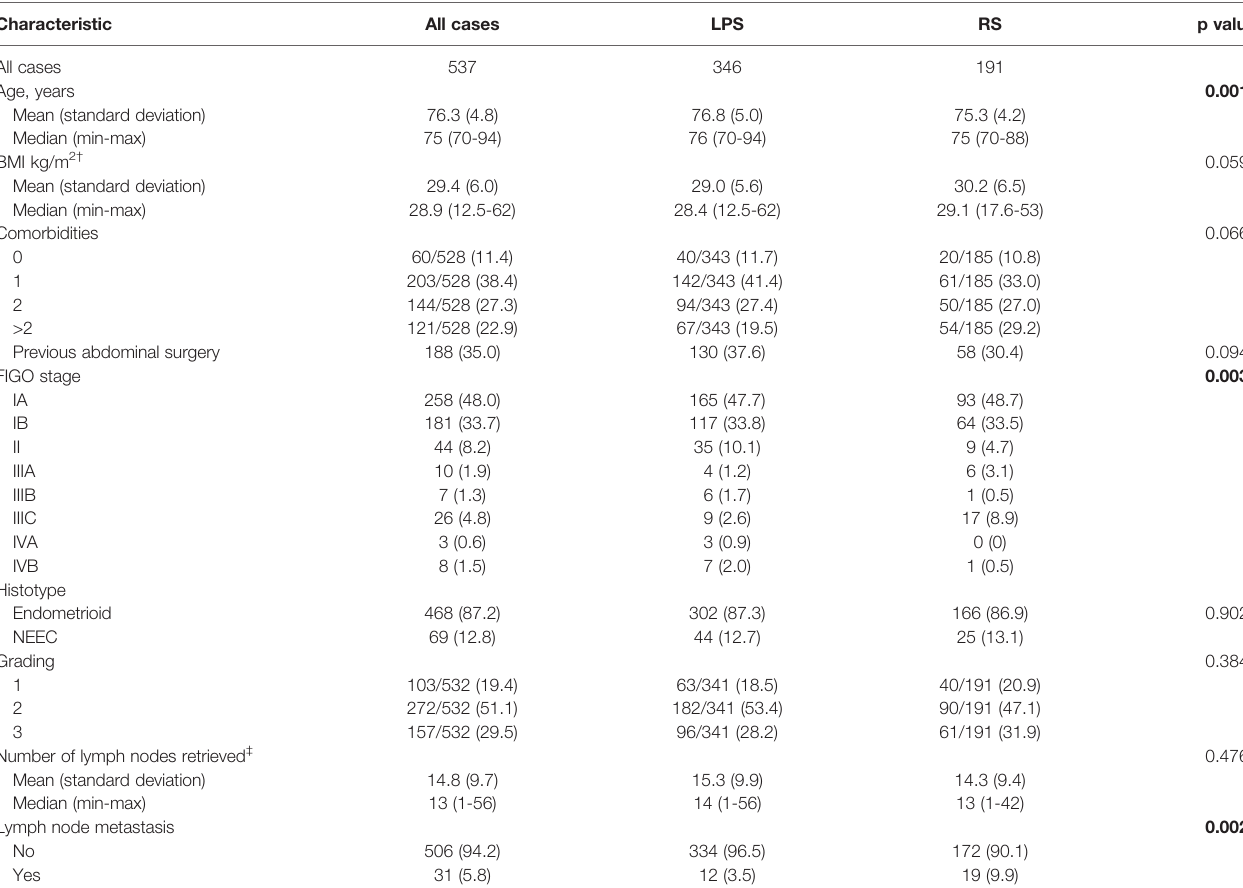
TABLE 1 | Clinical and pathological characteristics of 537 patients with endometrial cancer according to the type of surgery.